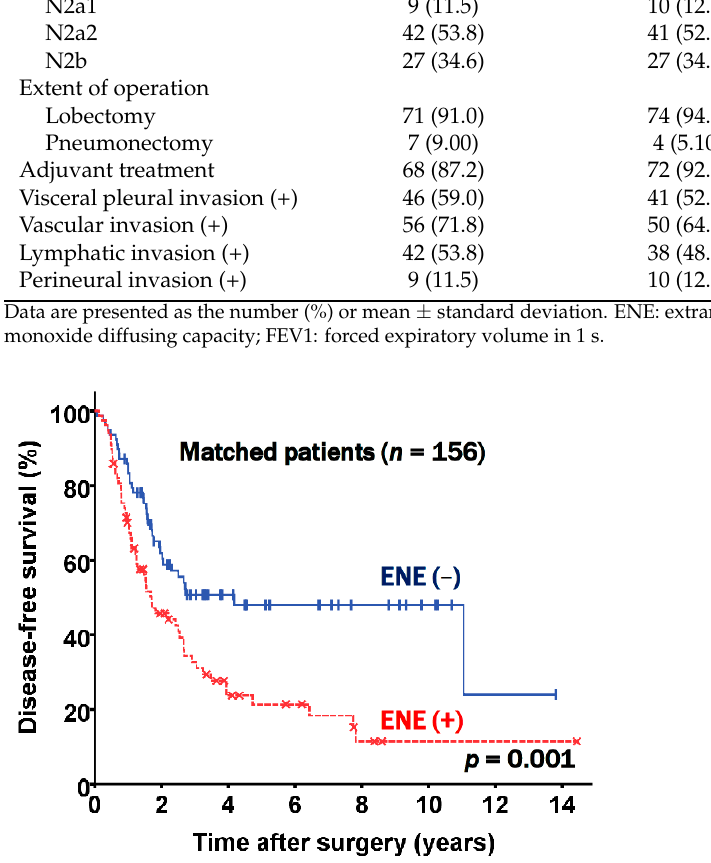
Figure 4. Disease free survival according to extranodal extension (ENE) status in matched patients.